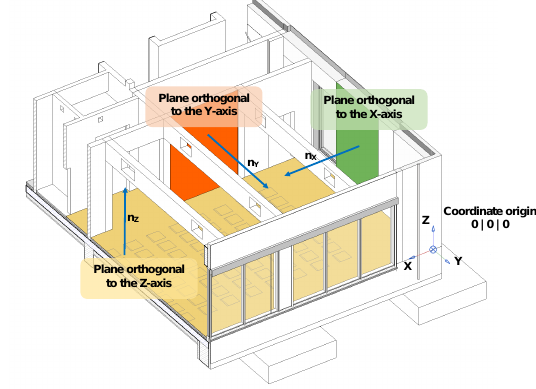
Here θ i and ϕ i are the polar components of a measured point (which are calculated from the Cartesian coordinates) and θ min and ϕ min are the minimum values of all points. ∆ θ and ∆ ϕ are the defined (scan file header) vertical respectively horizontal angular resolutions of the scan. Using Equation 1 and